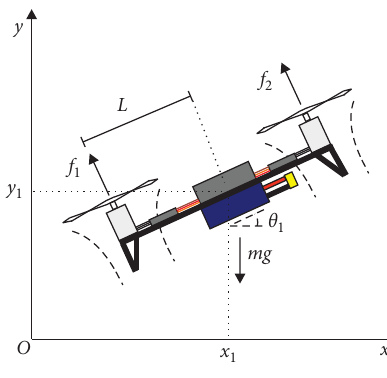
Figure 1: Diagram of the PVTOL